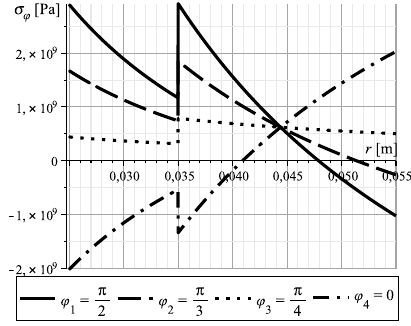
Figure 17: Plot of N ( φ ) (Example 5.2).